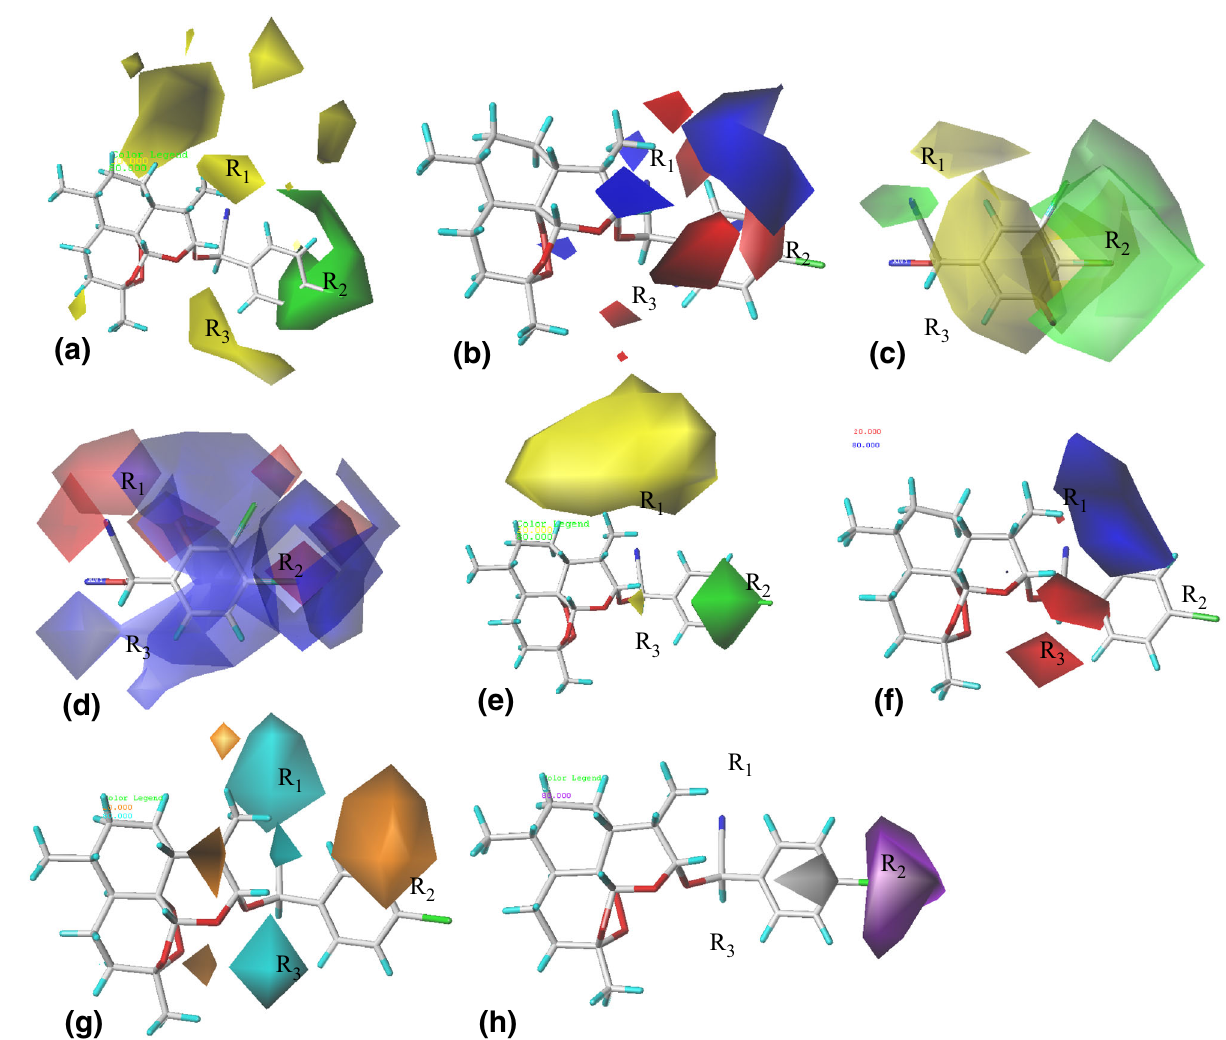
Fig. 4 3D QSAR models contour plots in combination with compound 14 as the template. a CoMFA steric field; b CoMFA electrostatic field; c TopomerCoMFA steric field; d TopomerCoMFA